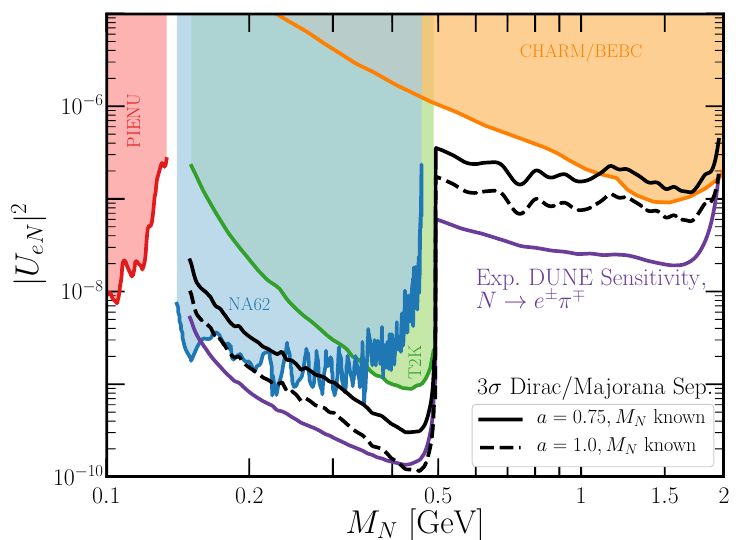
Figure 30 . Expected Dirac/Majorana separation capability in the (cid:12)nal state N ple curve is the expected DUNE sensitivity using the channel N this assumes that N is a Majorana fermion. The dashed black curve is the 3 (cid:27) Dirac/Majorana dis- tinction assuming perfect knowledge of M N and the e(cid:14)ciency factor a = 1. The solid black